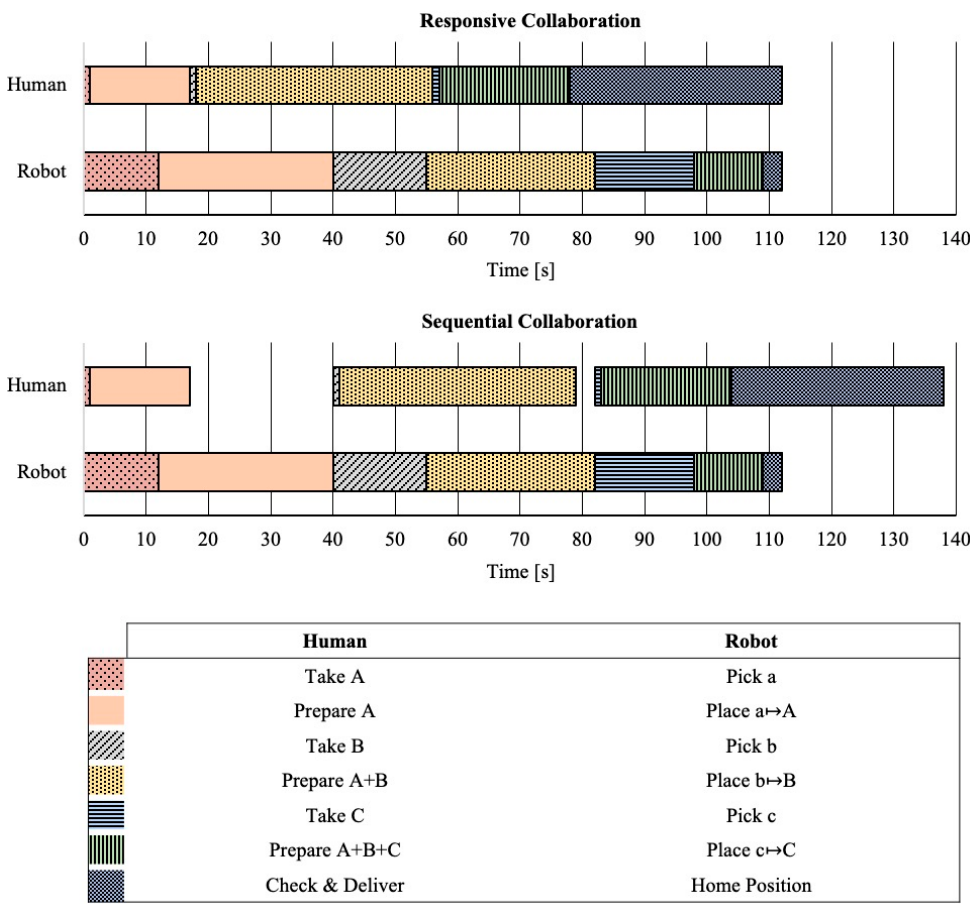
Figure 11. Workflow diagram of the assembly cycle for responsive and sequential collaborations.